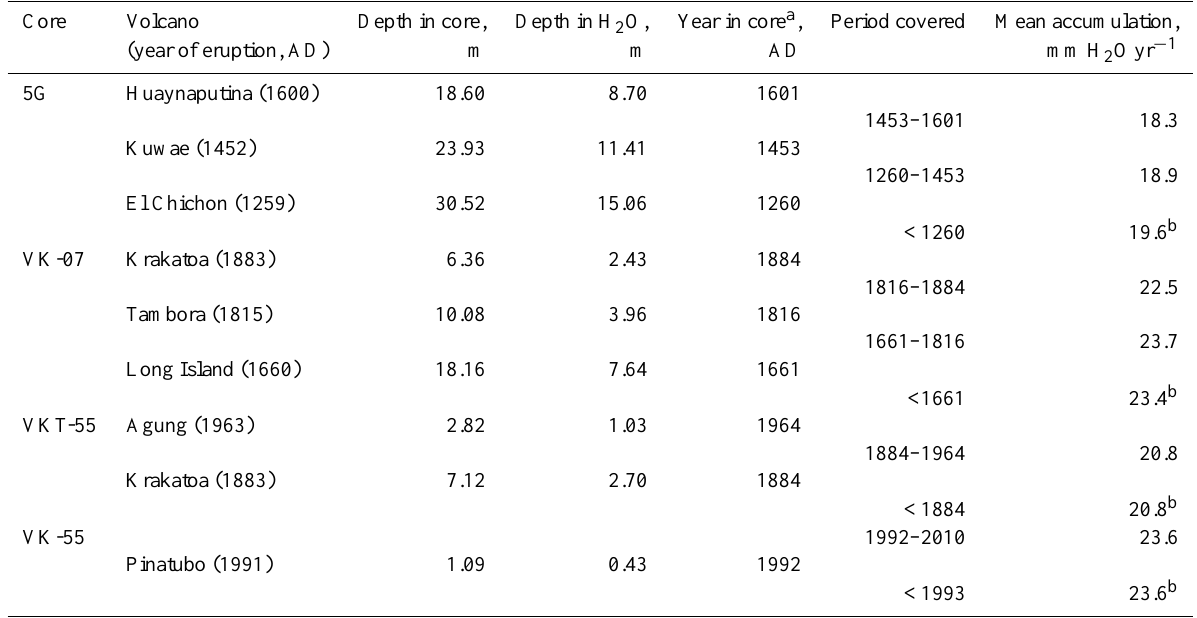
Table 2. Volcanic stratigraphic markers and their ages. Core Volcano Depth in core, Depth in H 2 O, Period